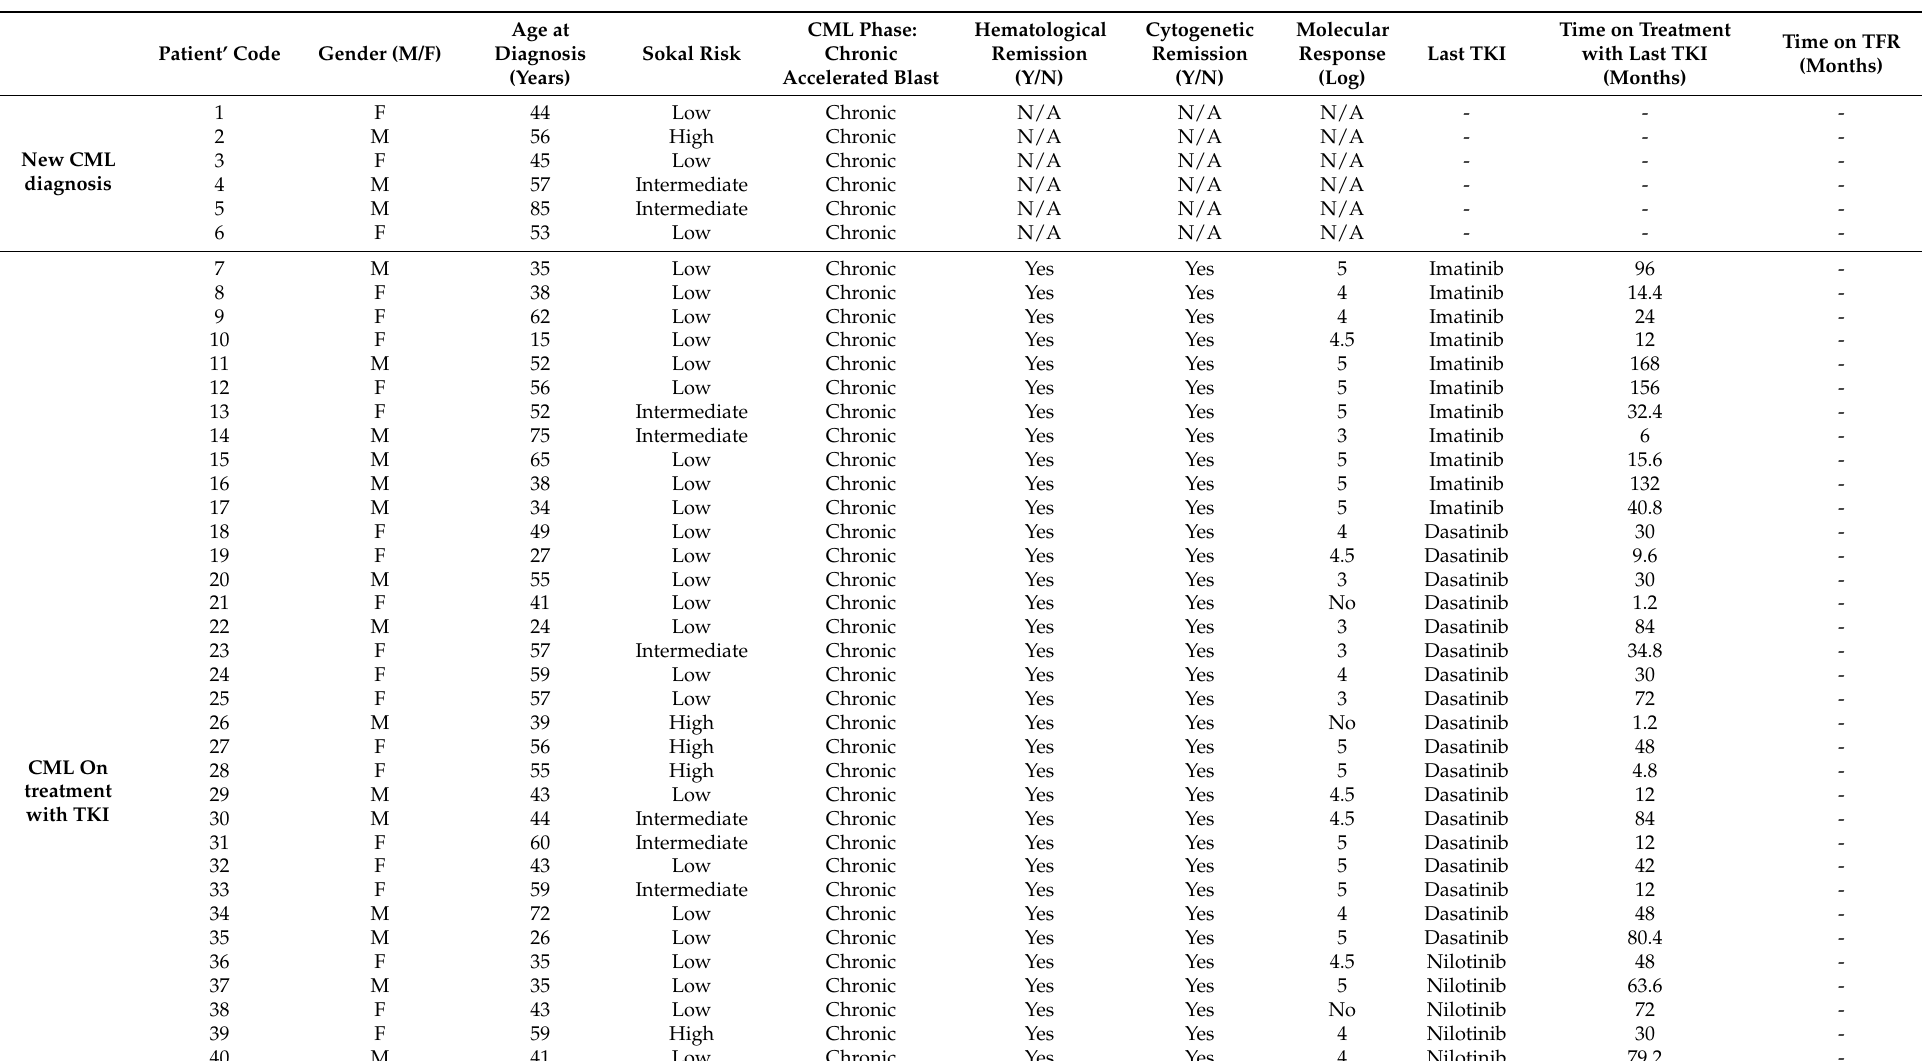
Table 2. Relevant clinical data of the patients with CML recruited for this